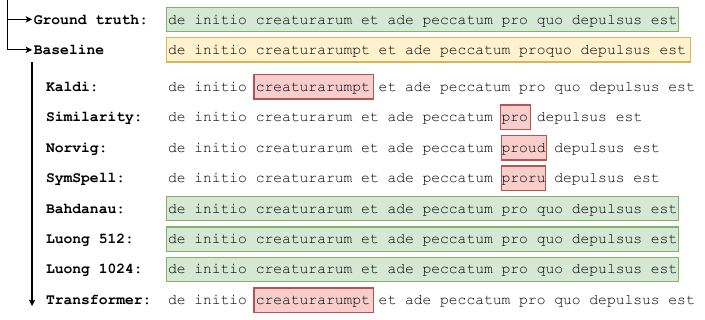
Figure 19. Correction sample in the Saint Gall dataset.